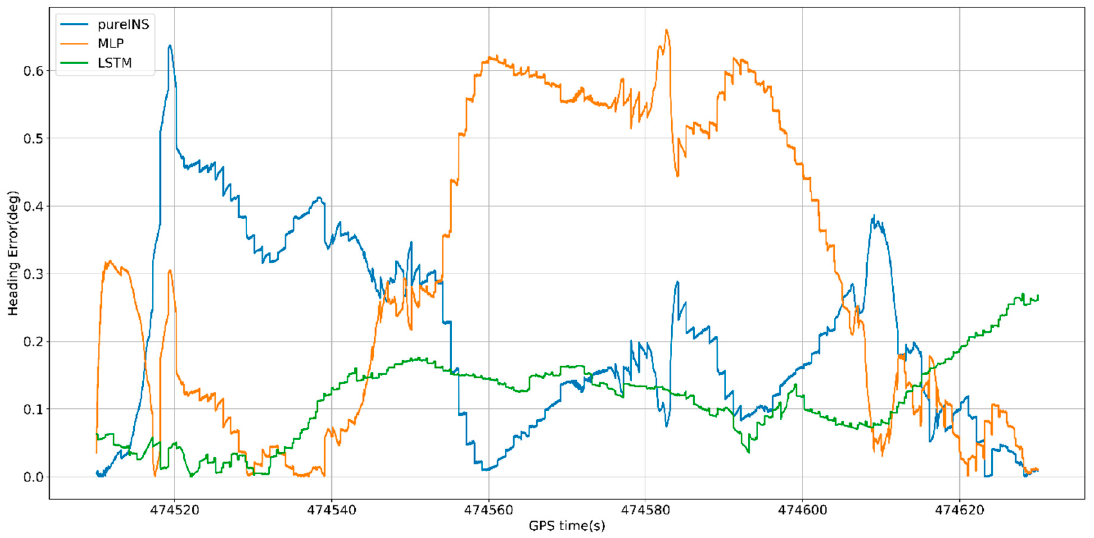
Figure 18. Heading errors of 120 s outages with different algorithms.